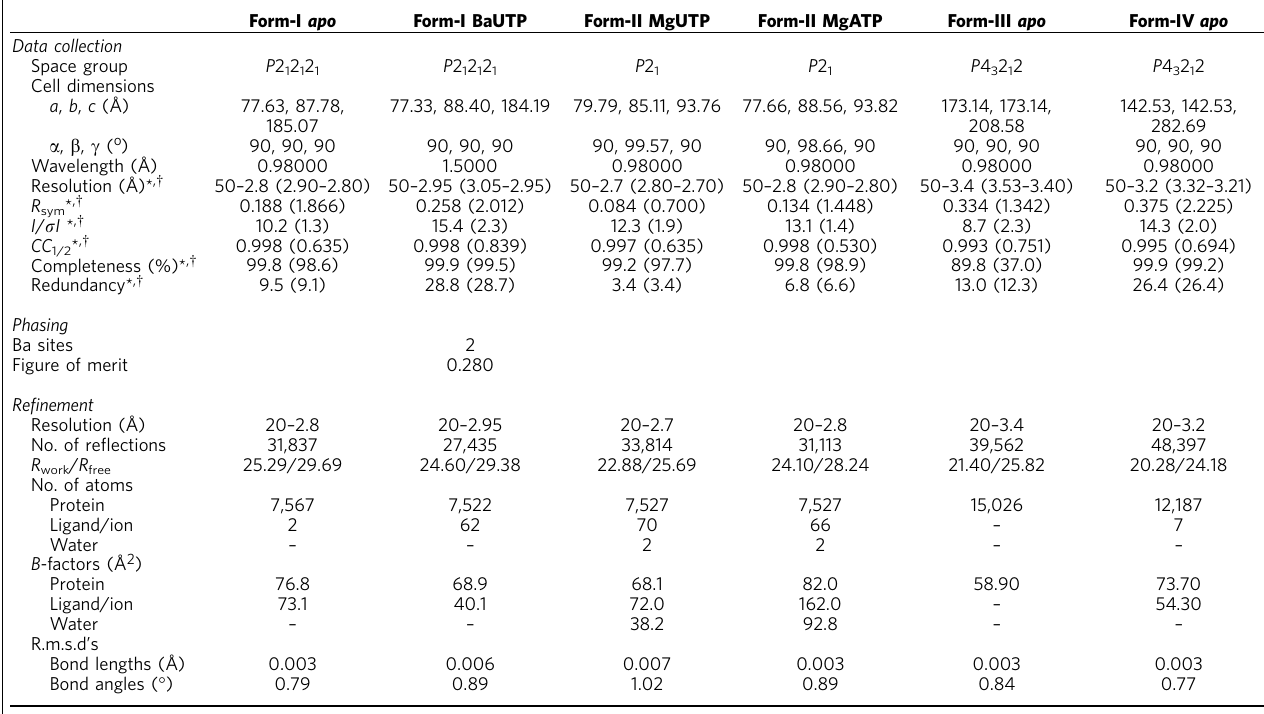
Table 1 | Data collection and refinement